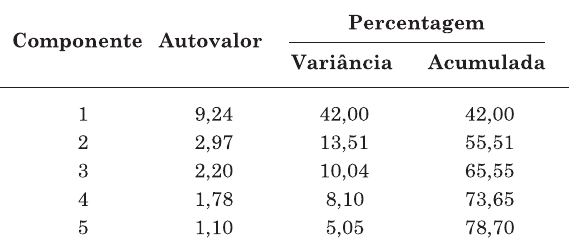
indicam redução na fertilidade do solo, caracterizada pela baixa disponibilidade dos demais nutrientes na área em